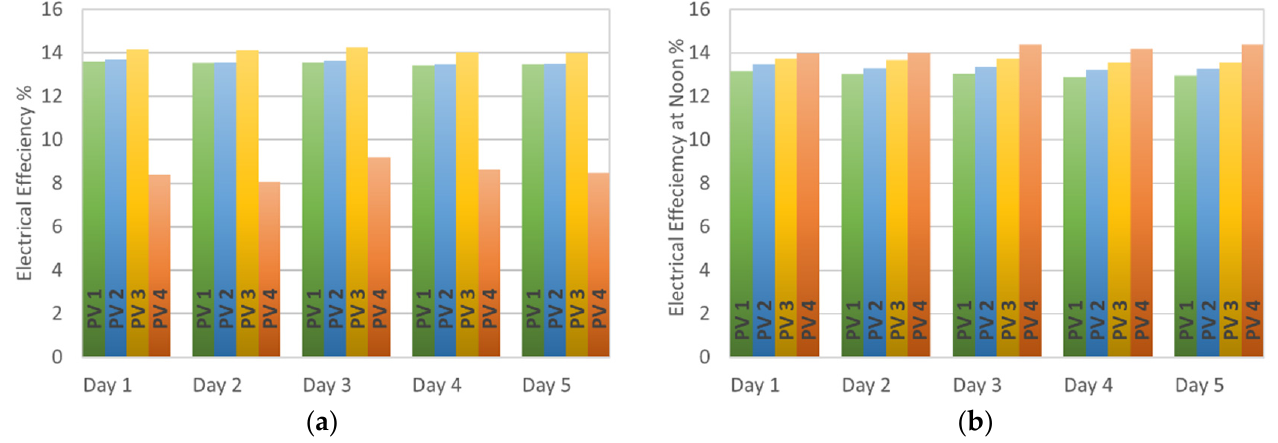
Figure 8. The average electrical efficiency of the four PV panels: ( a ) over the day from 9:30 to 16:30, and ( b ) around noon from 11:00 to 13:00.